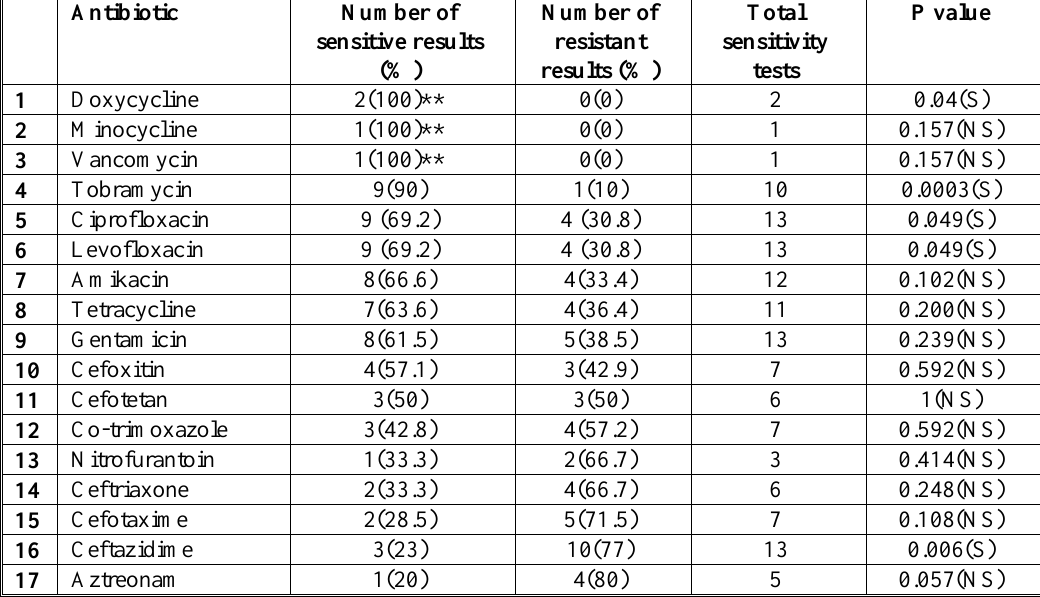
Table (5): Results of culture and sensitivity tests* Antibiotic Number of Number of sensitive results